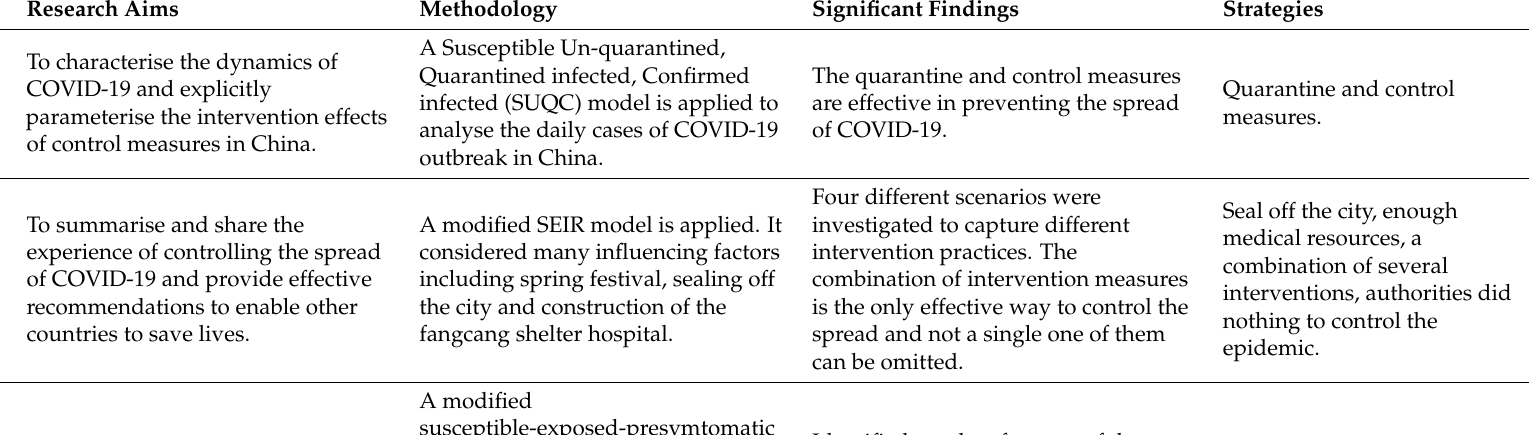
Table 1. Summary of the key findings of some important literature about COVID-19 modelling in China, the UK, and